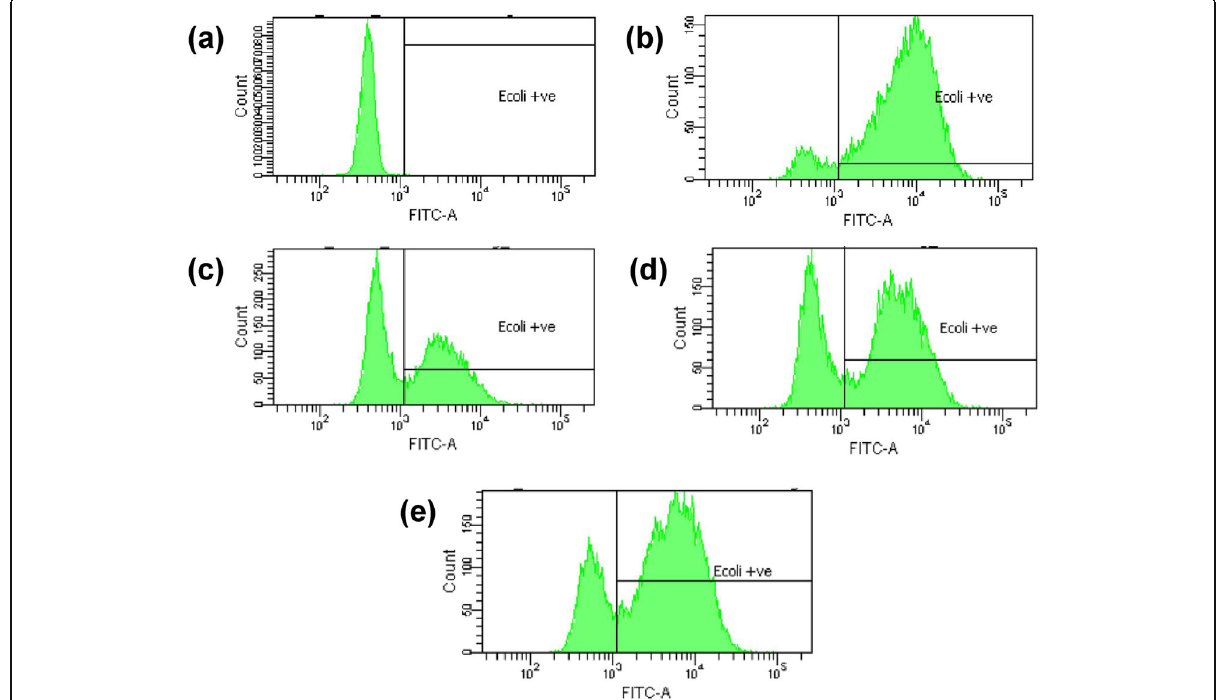
Fig. 5 E. coli engulfment by neutrophils treated with test samples i.e., ( a ) negative control, ( b ) positive control, ( c ) Z. zerumbet extract (50 μ g/mL), ( d ) Z. zerumbet essential oil (50 μ g/mL), ( e ) zerumbone (10 μ